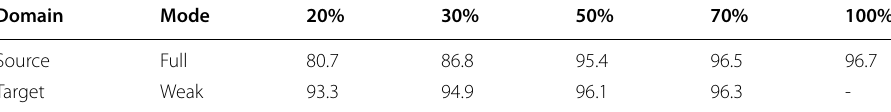
The Frame-mAP is shown in the table. We assume 20–100% usage of training data for fully supervised learning with our model in source domain. In target domain, we trained the network with the pre-trained model and the remaining data that only has classification annotations